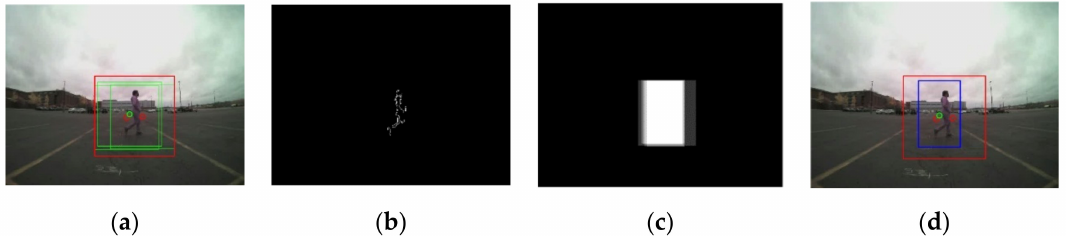
Figure 8. Refined ROI result from the proposed ROI generation algorithm: ( a ) the green bounding boxes are generated from the radar signals, the merged ROI is presented with the red square; ( b ) the first gradient of the motion image after binarization; ( c ) the temporal correlation map; ( d ) redefined ROI in the blue rectangular using the temporal correlation map.